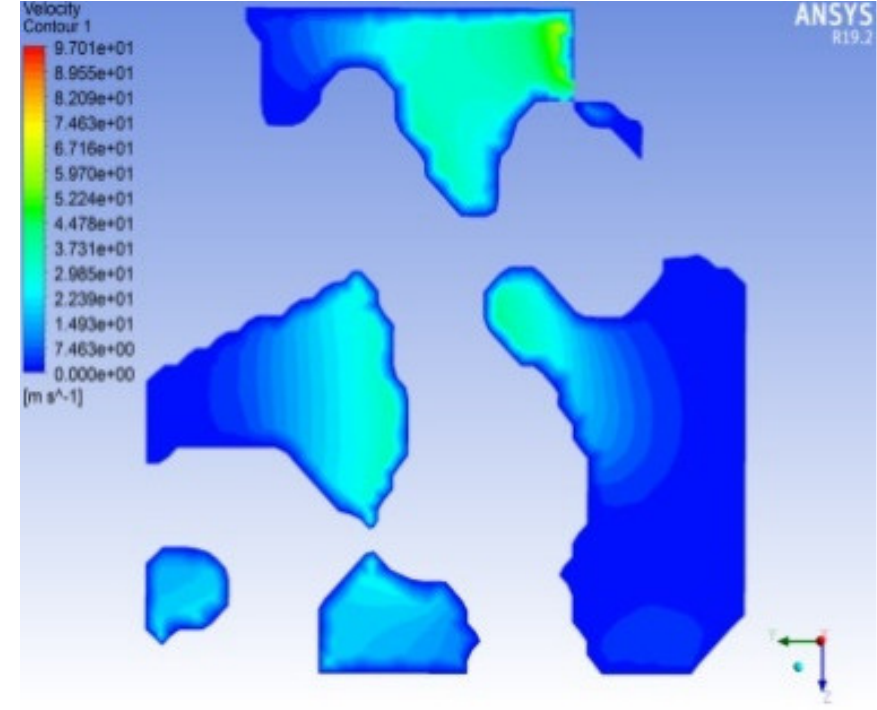
Figure 13. X, Y, and Z positive single channel seepage pressure cloud diagram of different cross-sections.